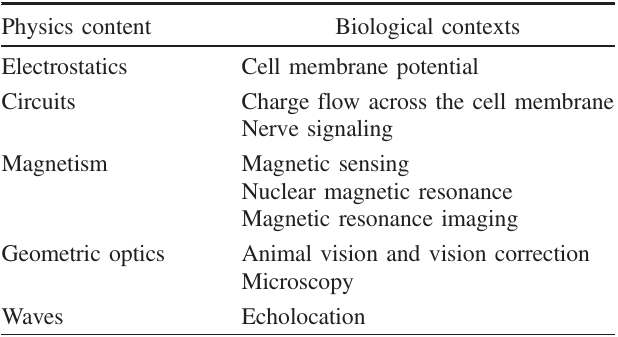
TABLE I. Each physical unit in the Swarthmore IPLS course was organized around a small number of key biological